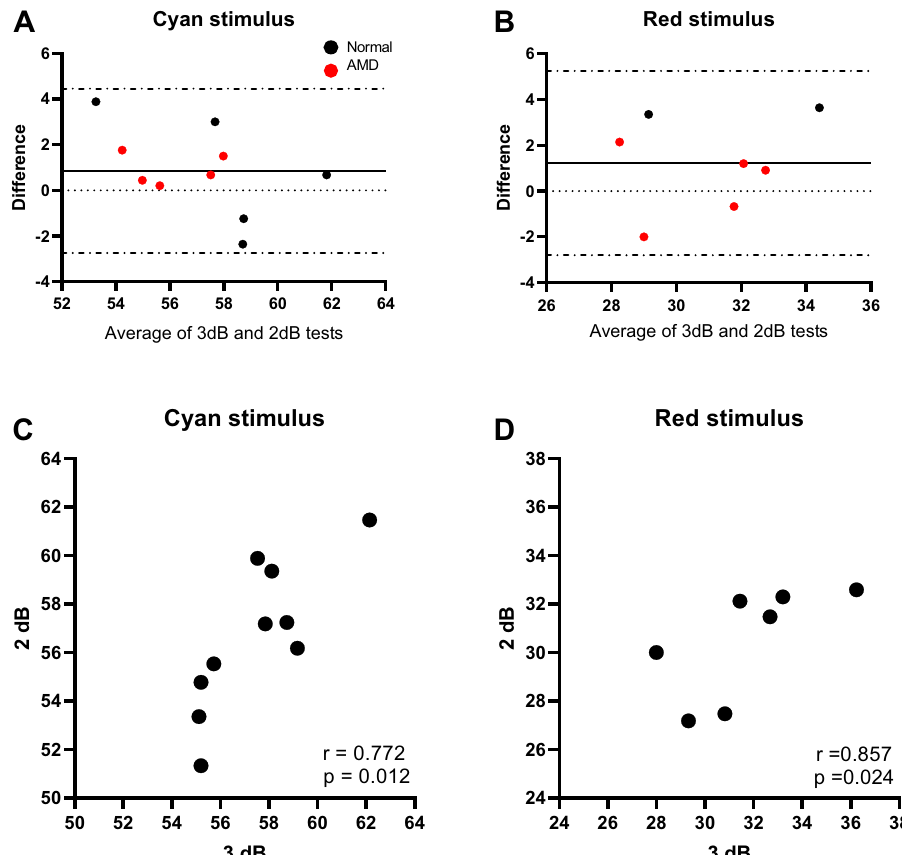
Figure 3. Bland–Altman plots with 95% limits of agreement (dashed lines) illustrates the difference in mean scotopic thresholds between 3 and 2 dB test strategies for both cyan ( A ) and red stimuli ( B ). Black dotted line represents the mean between the two measurements. Black circles represent healthy participants (N = 5 for cyan stimulus and N = 2 for red stimulus due to mechanical problems with the instrument) and red circles represent iAMD participants (N = 5 for both stimuli). The bottom two graphs show the correlations between 3 and 2 dB stimulus for the cyan ( C ) and red ( D ) stimuli.